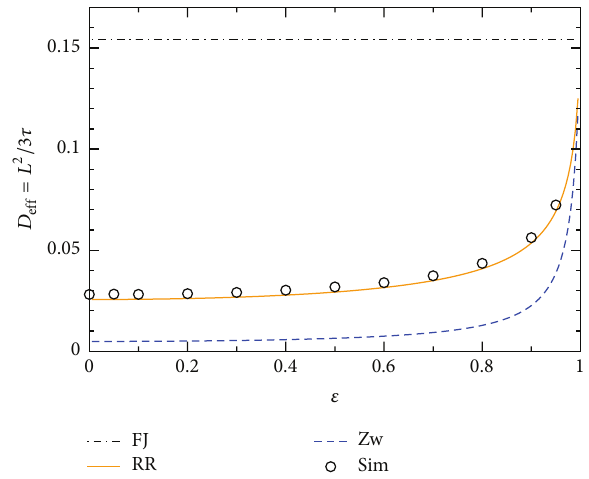
Figure 5: 𝐷 eff from (42), black dash and dot line, (43), blue dashed line, and (44), orange continuous line, as a function of the eccentricity 𝜀 of the elliptic tube (given 𝑅 = 1, 𝑎 = 0 . 05), compared with Data from computer simulations